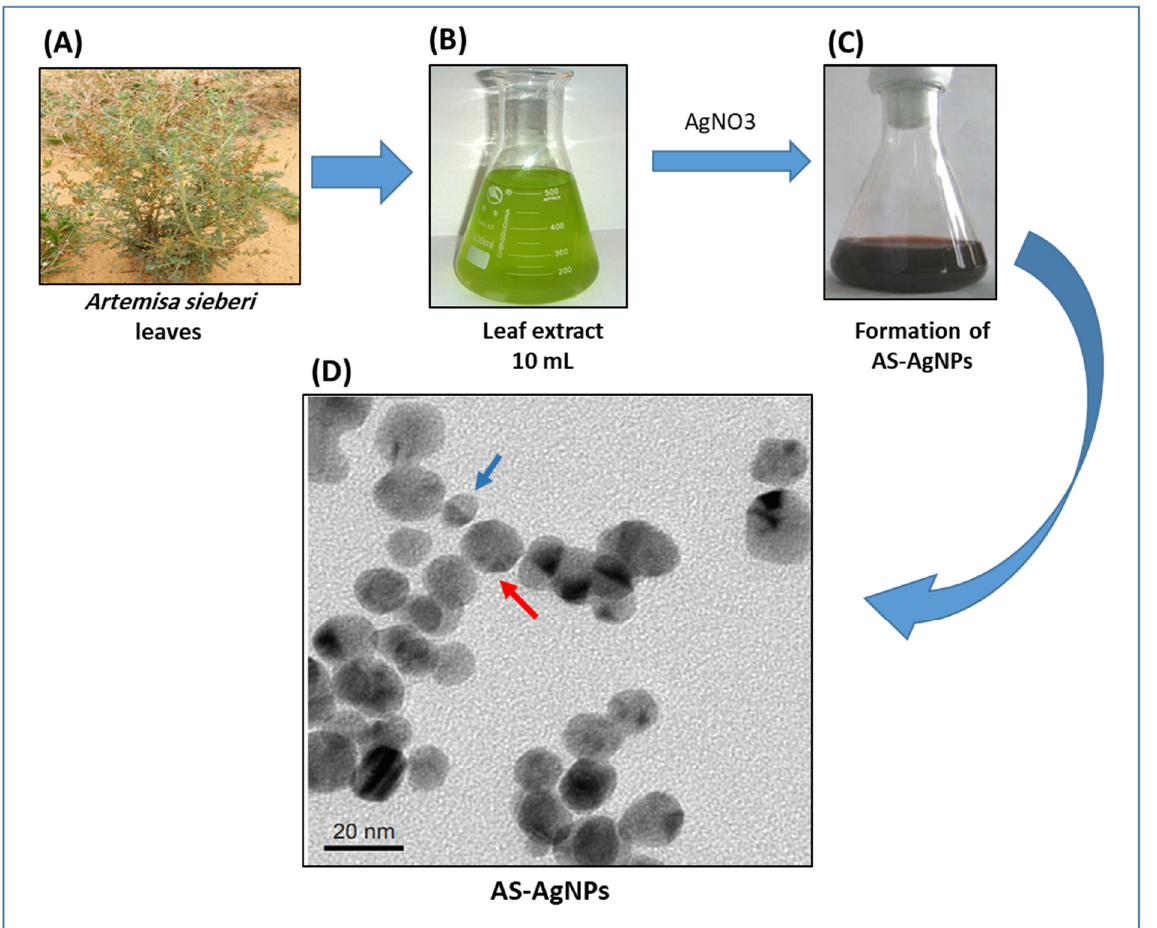
Figure 1. Biosynthesis of AS-AgNPs using A. sieberi leaf extract. ( A – C ) The biosynthesis of AS-AgNPs was performed by treating the leaf extract of A. sieberi with 1 mM AgNO 3 solution at 27 °C under dark conditions. ( D ) TEM micrograph of AS-AgNPs synthesized from A. sieberi leaf extract. TEM shows the size and shape of monodisperse AgNPs as a diameter range of 8 (blue arrow) to 22 (red arrow) nm and spherical.